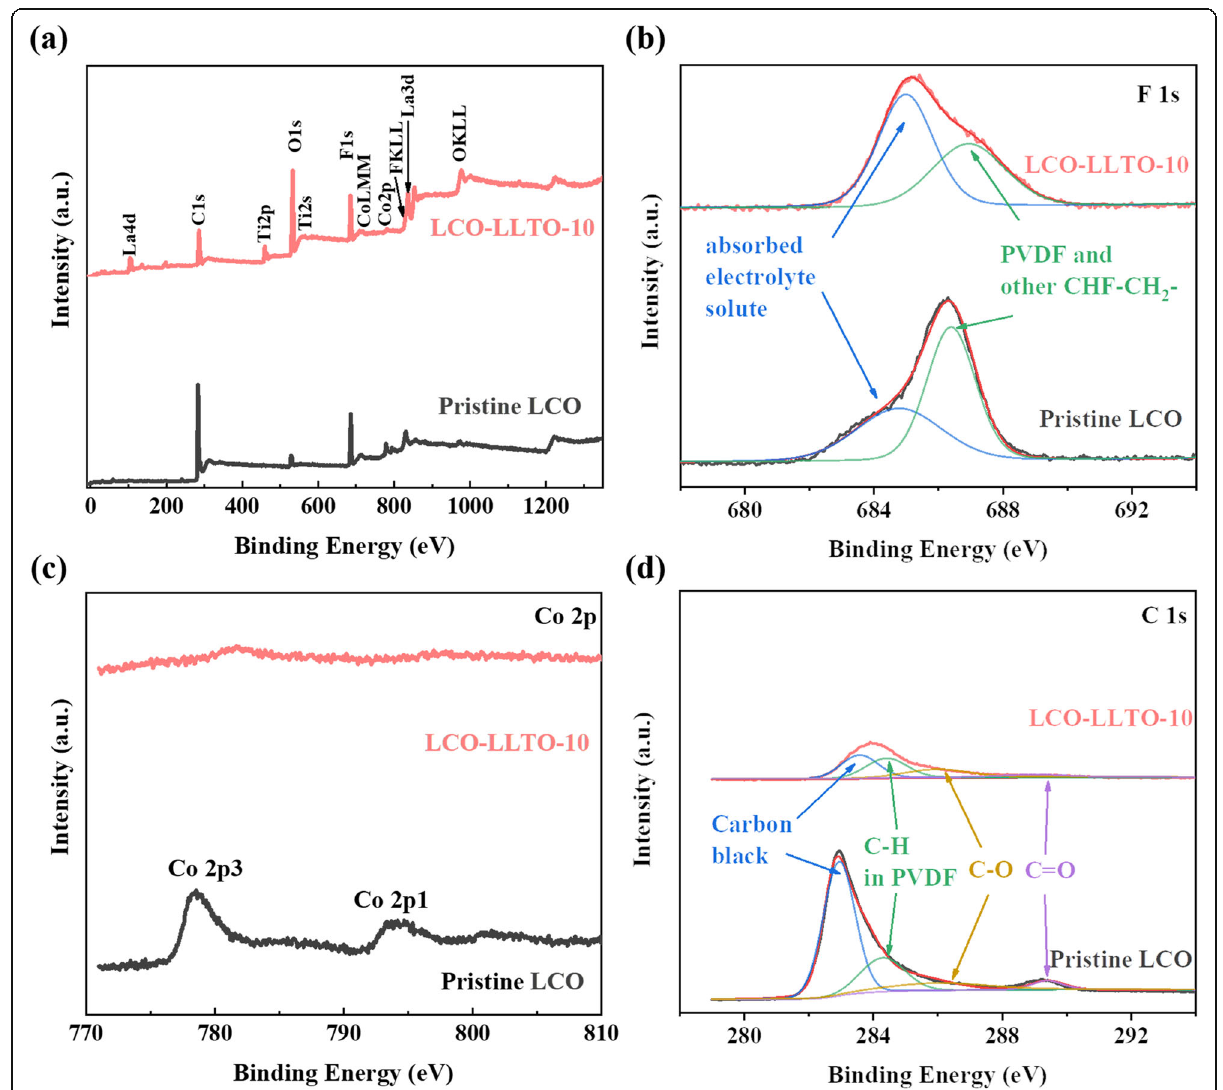
Fig. 4 XPS spectra of pristine LCO and LCO-LLTO-10 after 100 cycles. a Full spectra, b F 1 s spectra, c Co 2p spectra, and d C 1 s